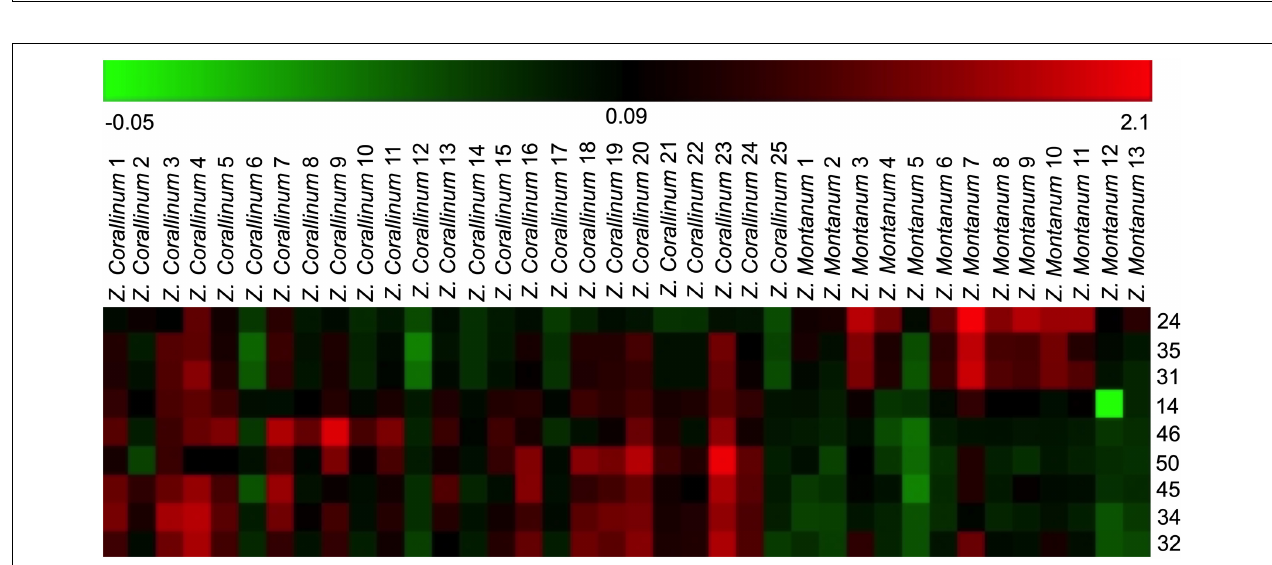
FIGURE 5 | Heatmap of identified distinguished metabolites of Z. corallinum and Z. montanum by the samples of known variety. Red and green colors indicate an increase and a decrease of metabolite level, respectively.